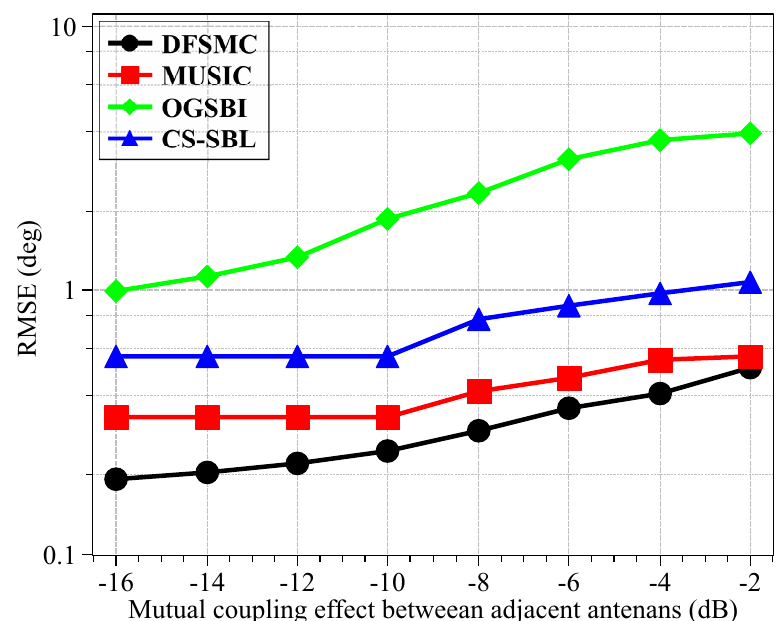
Figure 10. The direction estimation performance with different mutual coupling